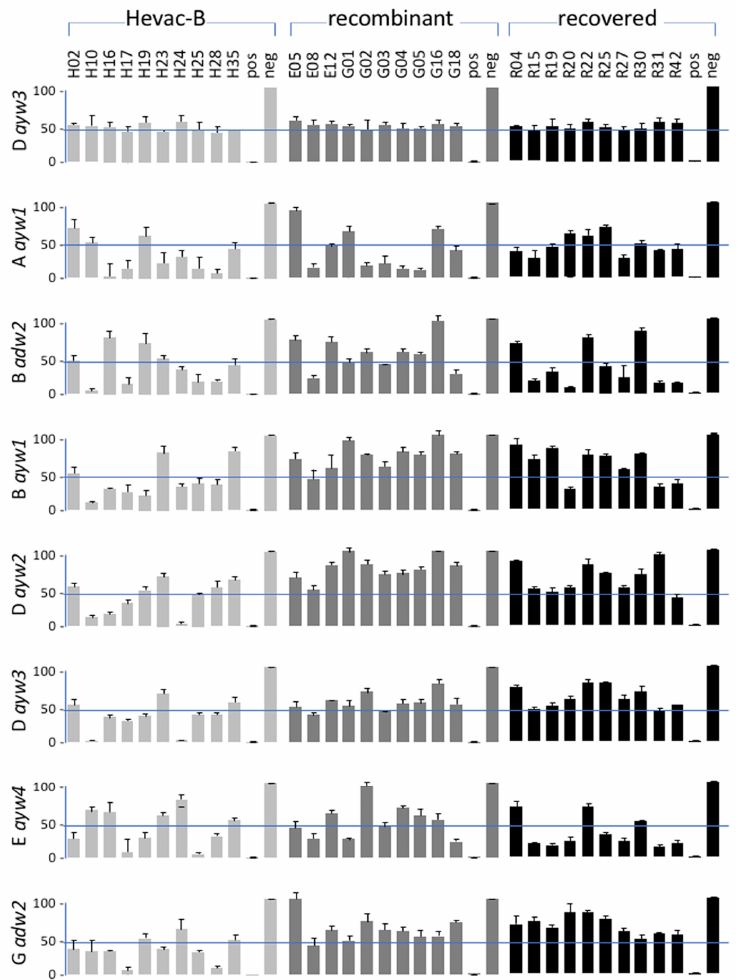
Figure 4. Analysis of vaccine-derived antibodies for their capacity to neutralize infectivity of virions coated with envelope proteins of di ff erent HBV genotypes/subtypes. Neutralization assay was per- formed using virions speci fi c of the HBV envelope proteins of genotypes/subtypes, as indicated on the left. Virions were pre-incubated with antibodies from 10 Hevac-B vaccinees, 10 recombinant vaccine recipients, and 10 individuals who recovered from infection. Each IgG antibody was used at the IC50 concentration that is de fi ned in Figure 4. Top histograms show the results of infection in percent of infection in the presence of anti-HBs-negative control (neg) with virions bearing the en- velope proteins of the HBV genotype D ayw3 reference. Histograms below show the results ob- tained with inoculums containing virions coated with envelope proteins of the indicated geno- types/subtypes.